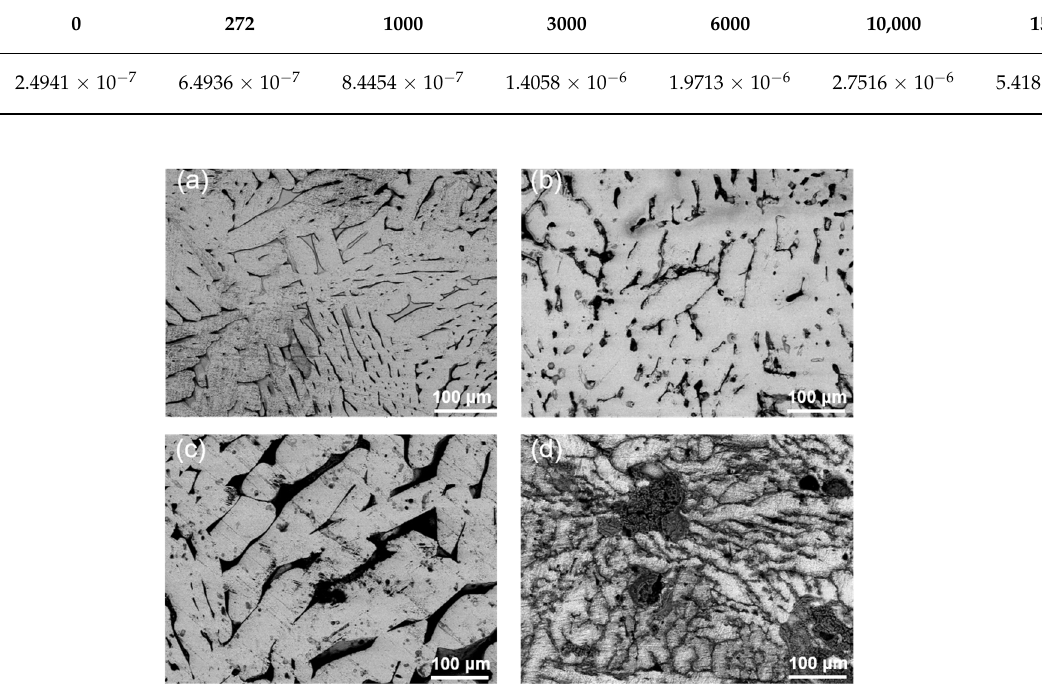
Figure 12. Potentiodynamic polarization curves ( a ), and the corrosion potential and corrosion rate ( b ) of Z3CN20-09M stainless steel at different aging times. Table 2. The corrosion current of Z3CN20.09M cast stainless steel after thermal aging.